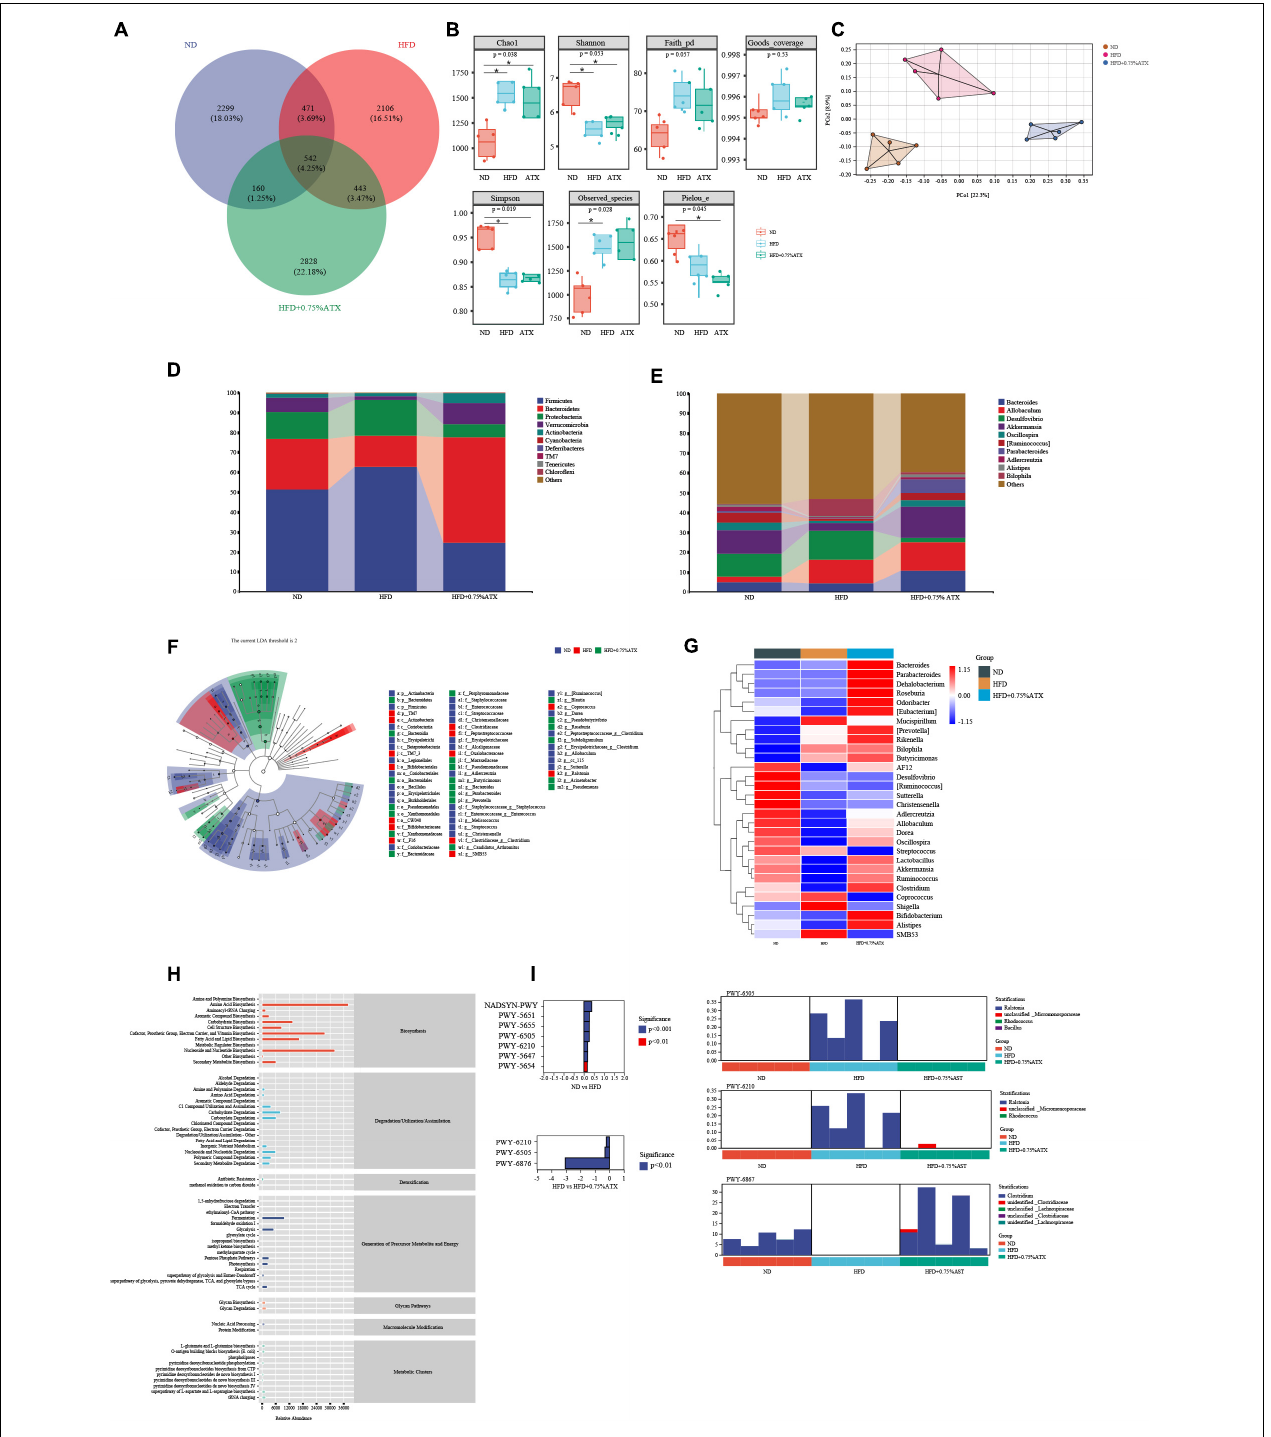
FIGURE 6 | Astaxanthin regulated the gut microbiota. (A) The Venn diagram. (B) Evaluation of Alpha Diversity Index including Chao1, Simpson, Shannon, Pielou’s evenness, observed species, Faith’s phylogenetic diversity and Good’s coverage index values. Data were analyzed using a one-way ANOVA and are expressed as the mean ± SD. ( n = 5). “*” P < 0.05 versus ATX-treated HFD-fed mice. (C) PCoA of unweighted UniFrac distance from beta diversity analysis. (D) Phylum abundance graph genus levels. (E) Genus abundance graph. (F) Species taxonomy branch map based on LEfSe analysis. (G) The heatmap of the 30 bacterial genera with the largest differences in abundance were selected, according to the unweighted UniFrac distance of the intestinal content samples. (H) Predicted the abundance map of MetaCyc secondary functional pathways. X-coordinate: the abundance of functional pathways, Y-coordinate: the MetaCyc secondary functional pathway. (I) Analysis of differences in metabolic pathways ( left ) and species composition in different MetaCyc pathways ( right ).